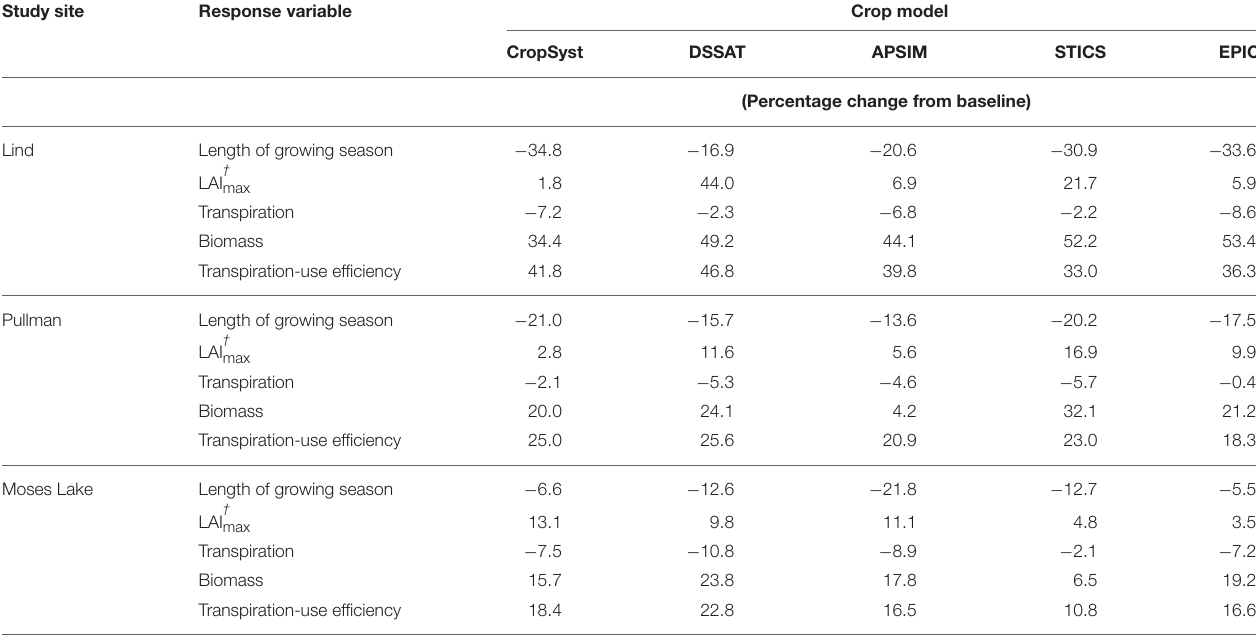
TABLE 6 | Percent changes with respect to baseline (1979–2009) values of selected process components contributing to changes in winter wheat yield during the 2070 period (2055–2085) and representative concentration pathway 8.5. Study